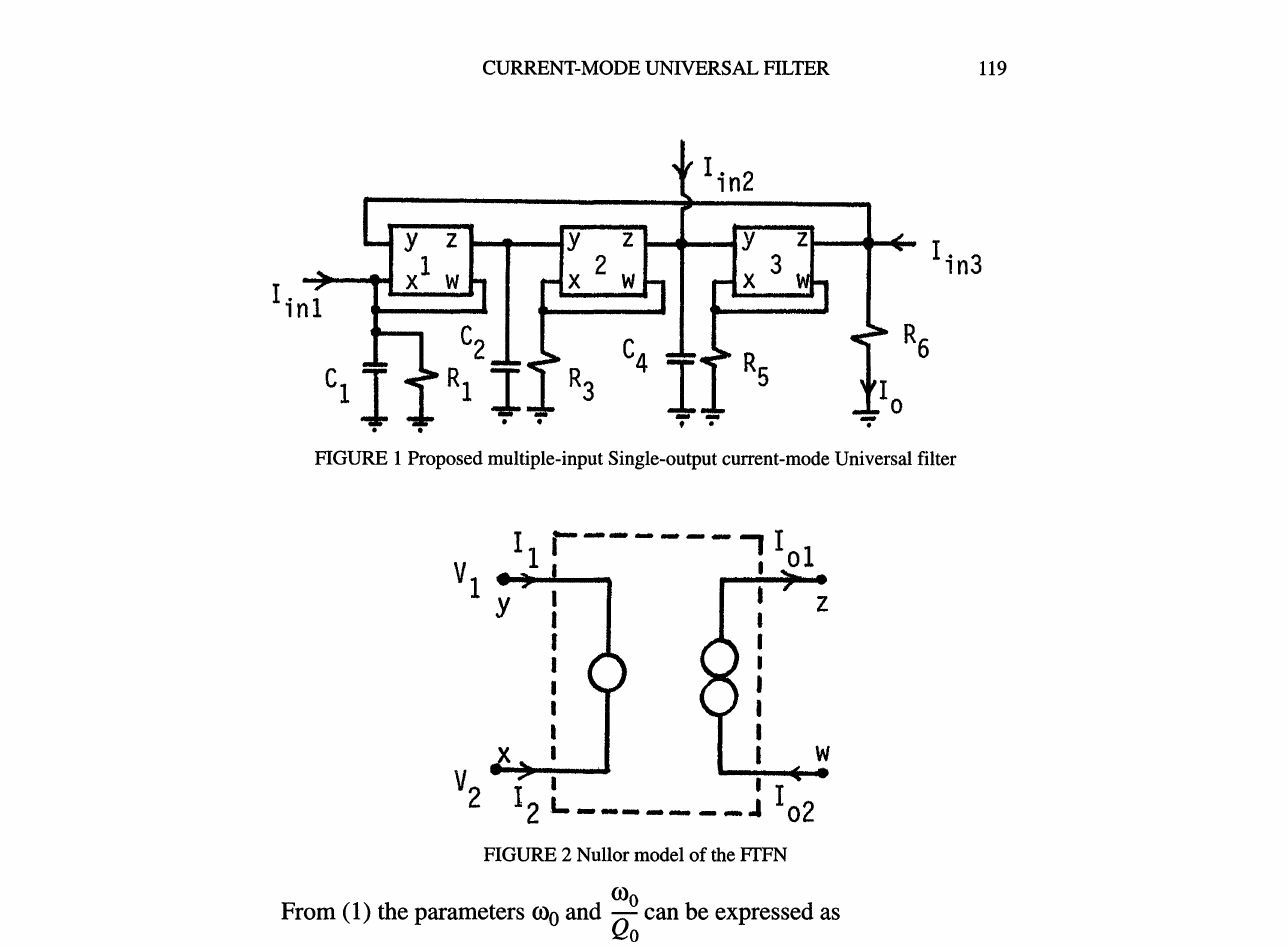
FIGURE 2 Nullor model of the